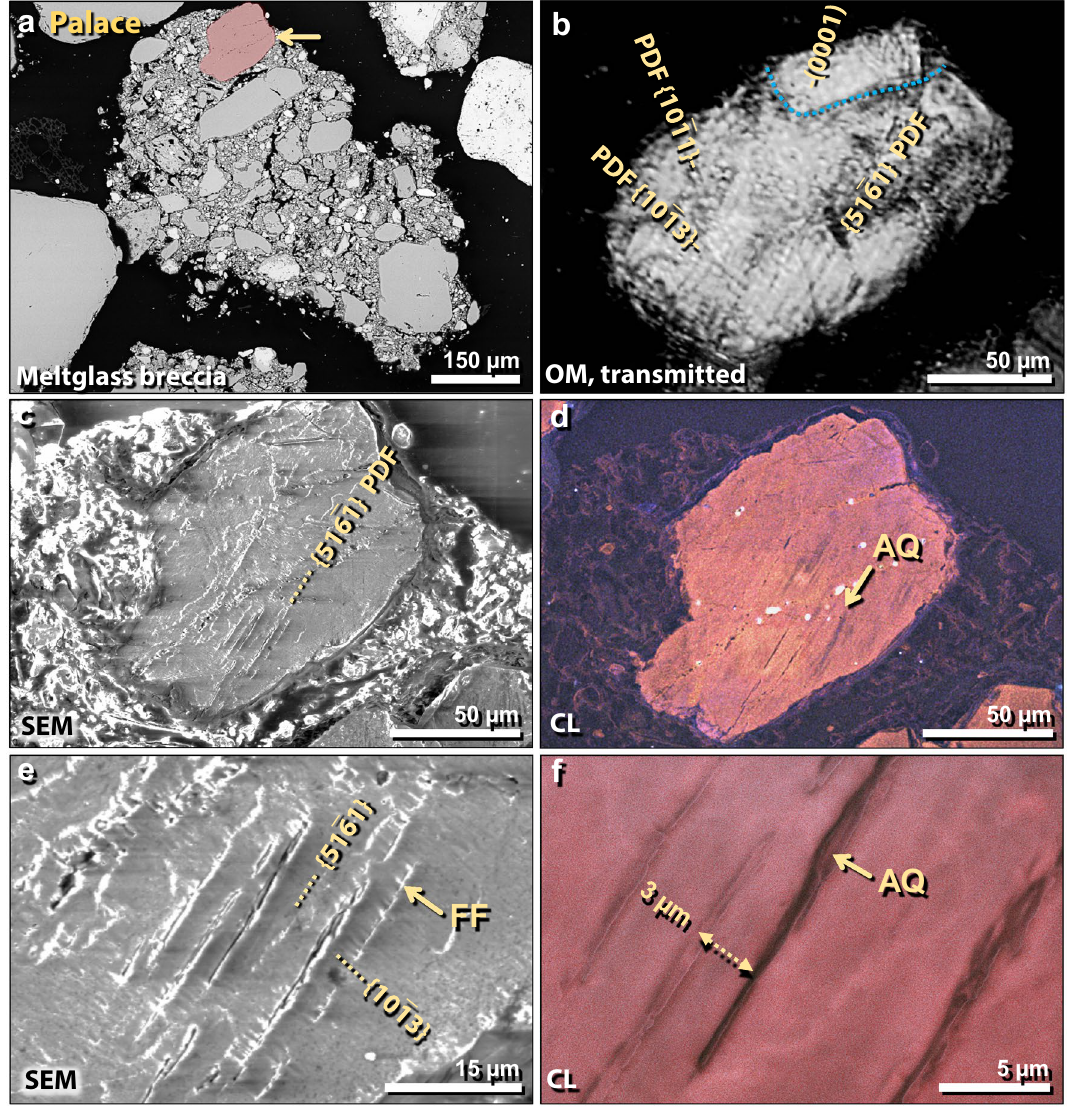
Figure 18. Shocked quartz grain from TeH palace. ( a ) SEM image of a 750-µm-wide fragment of meltglass breccia from the palace, containing melted and partially melted grains surrounded by Ca–Al–Si meltglass. Shocked quartz grain in red at arrow; other grains are not shocked. ( b ) Transmitted light photomicrograph using an optical microscope (OM); 155-µm-wide HF-etched quartz grain is same as in panel ‘ a ’. Lamellae are labeled as Miller-Bravais indices (hkil) (ANIE program 55 ). Three sets in lower crystallite are all closely-spaced PDFs crossing the entire crystallite. Blue dotted line marks the boundary of one crystallite in polycrystalline grain, containing only one set of lamellae, the (0001) plane with its pole parallel to the c axis. ( c ) SEM image of same HF-etched grain displaying visible lamellae, which excludes them as tectonic lamellae. ( d ) SEM-CL image of same grain showing multiple closely-spaced non-luminescent lamellae (black), indicative of amorphous quartz (AQ). ( e ) Close-up SEM image of same grain, showing visible lamellae, all of which display short-range feather features (FF) that form at ≥ 7 GPa. ( f ) SEM-CL close-up image, showing black non-luminescent centers of lamellae, indicative of amorphous quartz. Lamellar spacing is ~ 3–5